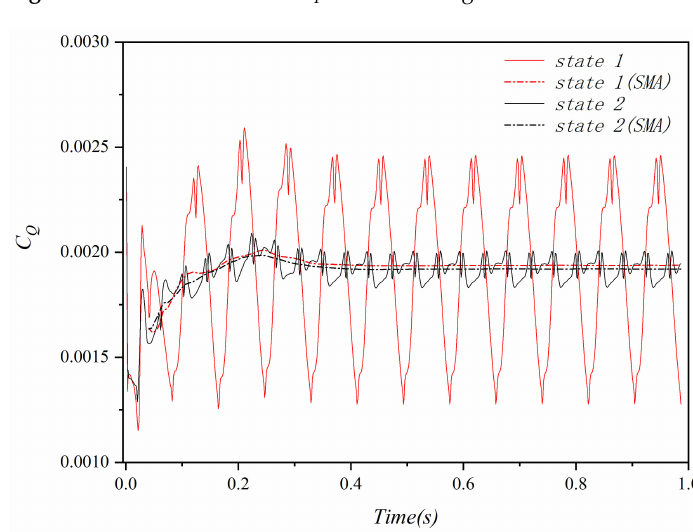
Figure 20. The isolated rotor C Q in forward flight.